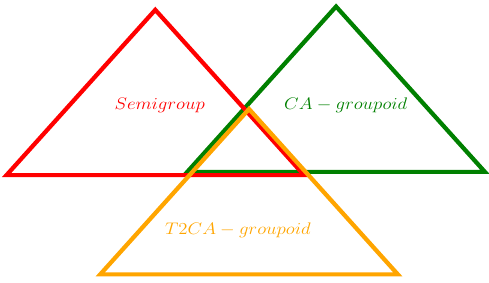
Figure 2. The relationships among the T2CA-groupoid, CA-groupoid and semigroup. In Figure 2, there are three triangles of different colors. The red triangle represents the semigroup; the green triangle represents the CA-groupoid; and the orange triangle represents the T2CA-groupoid. We can see from Figure 2 that between the three algebraic structures—the semigroup, CA-groupoid and T2CA-groupoid—the intersection of any two is the proper subset of the